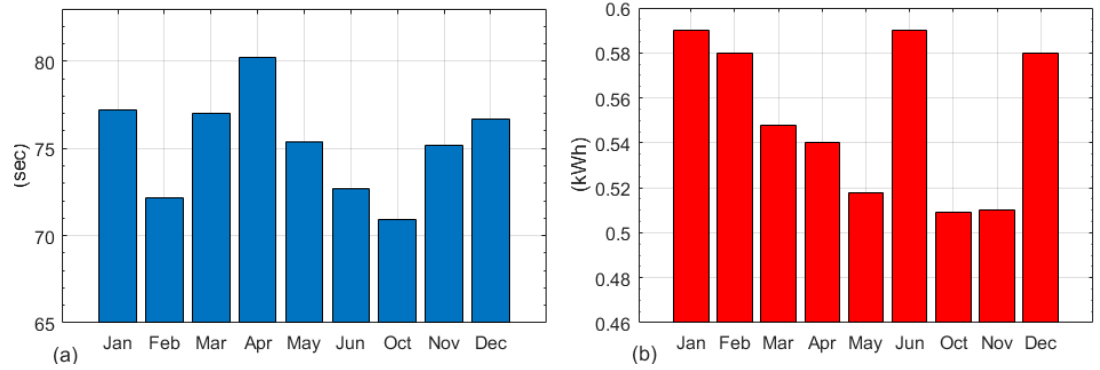
Figure 2. ( a ) Mean travel time, ( b ) mean energy consumption per bus Figure 2. ( a )Mean travel time, ( b ) mean energy consumption per bus trip.